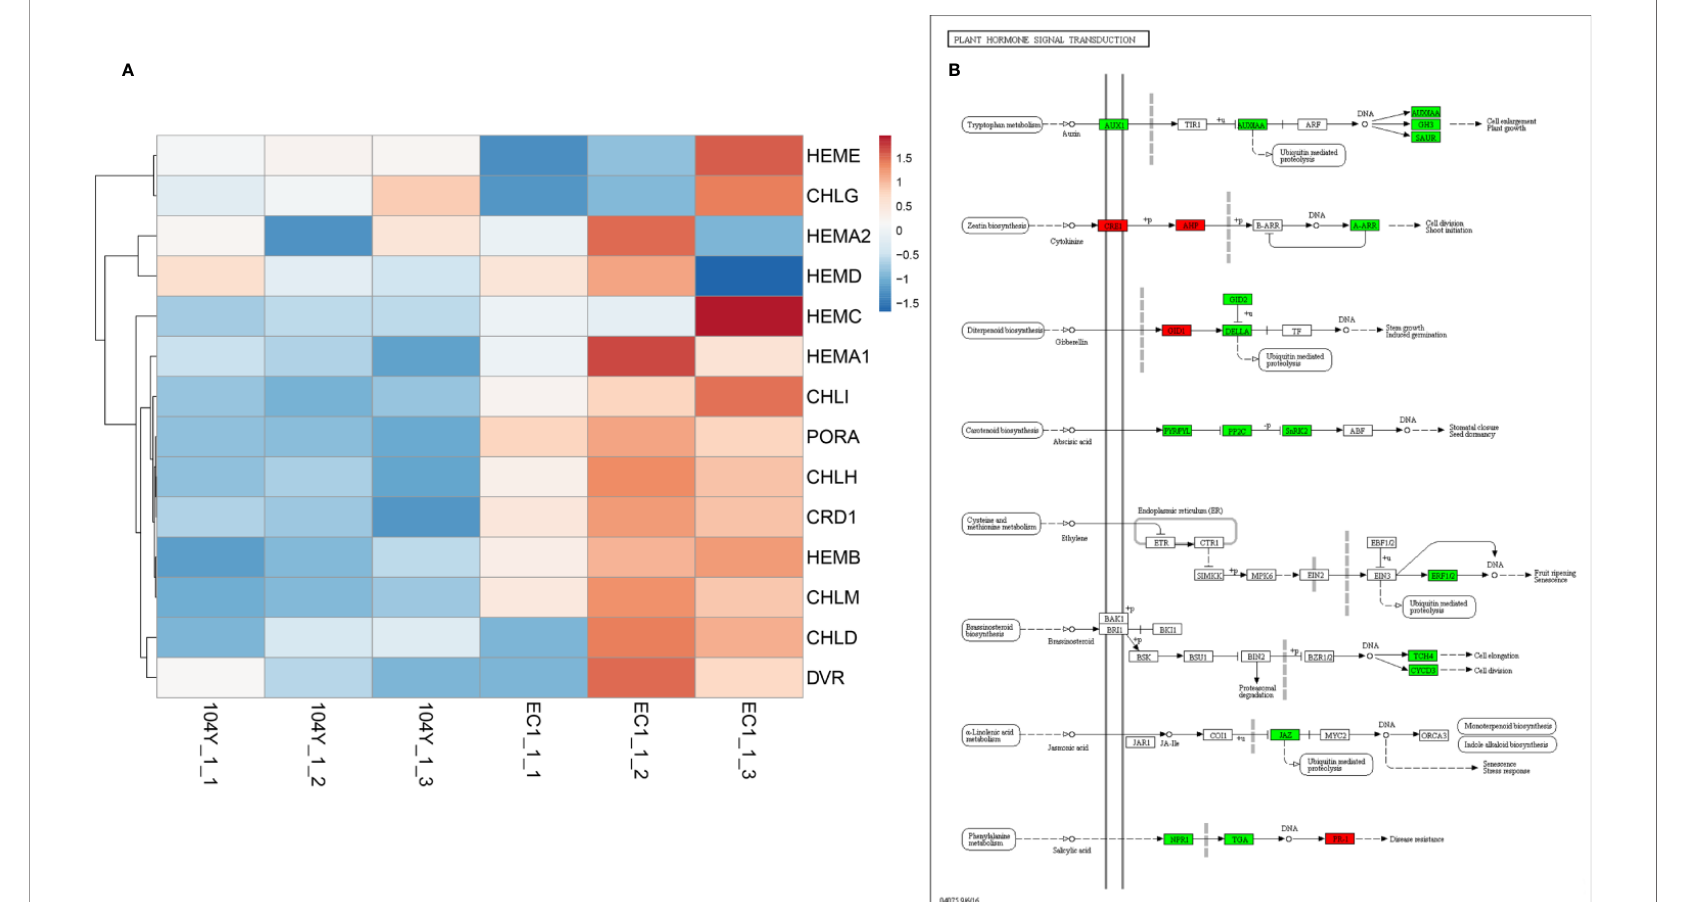
FIGURE 7 | The expression levels of the genes involved in chlorophyll biosynthesis (A) and plant hormone signal transduction (B)